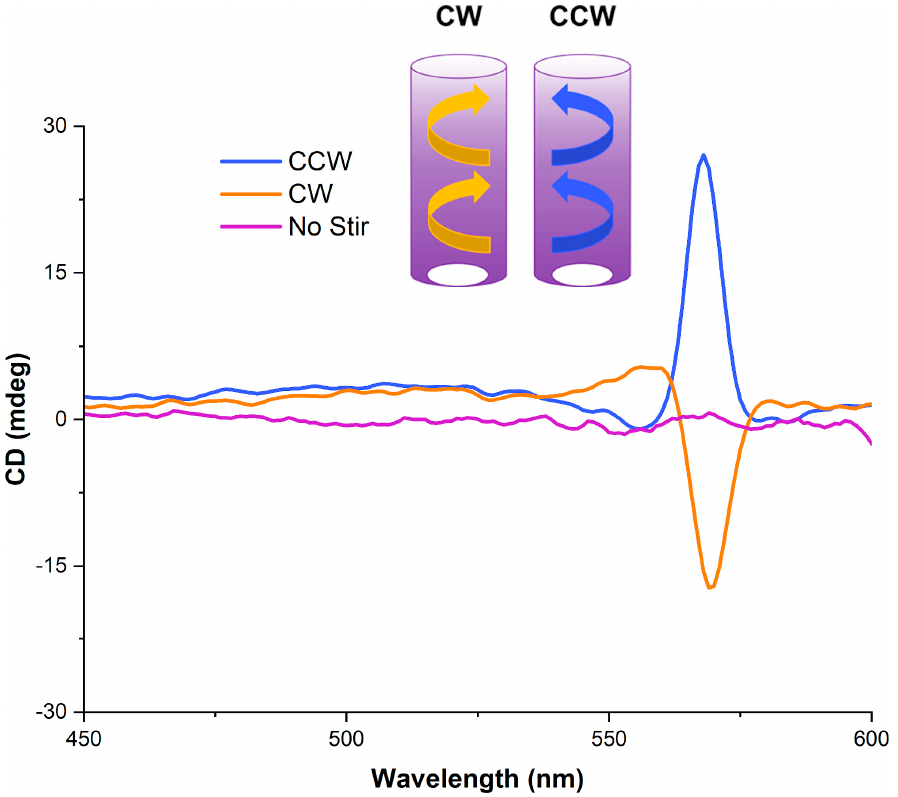
Figure 3. CD spectra, recorded at 21 °C, from stirring solutions of S0271 at 25 µM in Milli-Q water (pH 7.12, 18.2 Ω cm − 1 ) in opposite directions (CW—orange and CCW—blue), whilst the non-stirred trace is shown in purple.